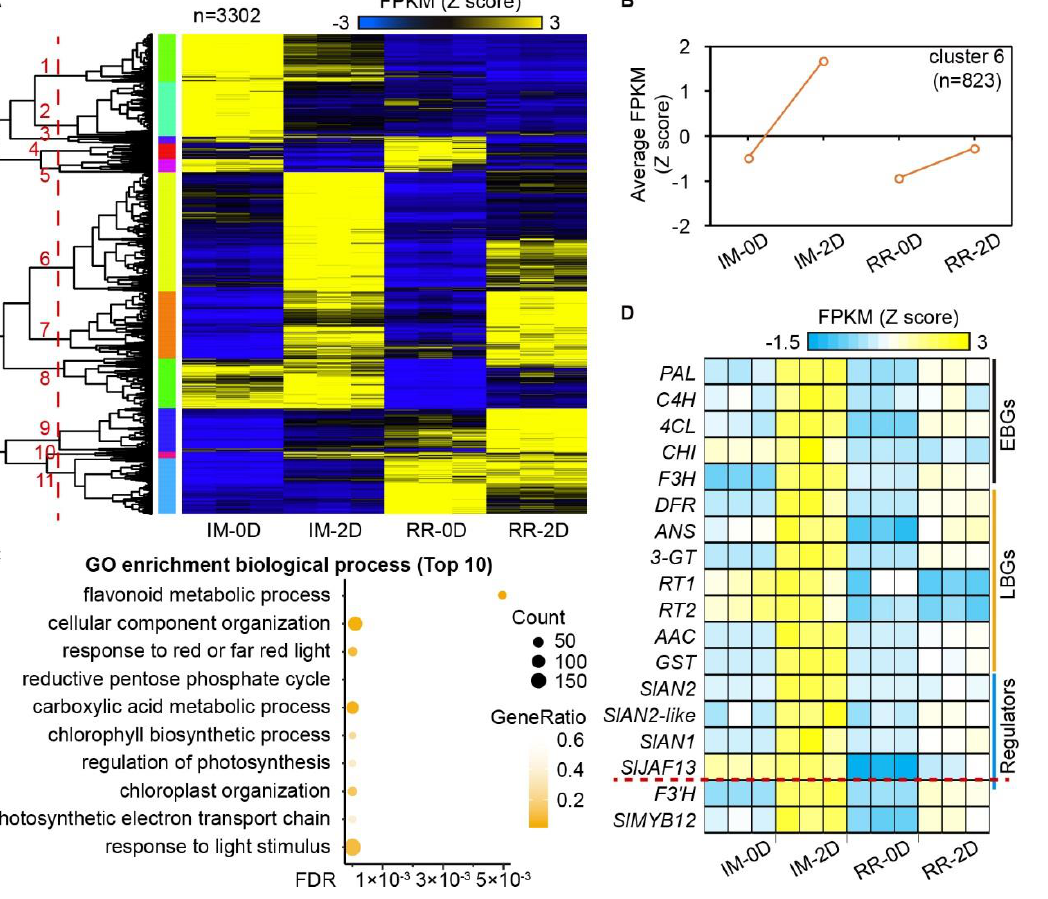
Figure 2. Global gene expression patterns in the immature and red ripening fruits before and after removing bags. ( A ) The expression profiles of 3302 differentially expressed genes (DEGs) in the immature and red ripening fruits before and after removing bags. The DEGs were clustered into 11 groups, indicated by the orange lines. ( B ) The expression profiles of genes in cluster 6. The y axis indicates the normalized FPKM (Z score). ( C ) The top ten enriched GO terms (biological process) by genes from cluster 6. ( D ) The expression of differentially expressed flavonoid-related genes between the immature and red ripening fruits. EBGs and LBGs mean early and late biosynthetic genes, respectively; IM—immature stage; RR — red ripening stage.